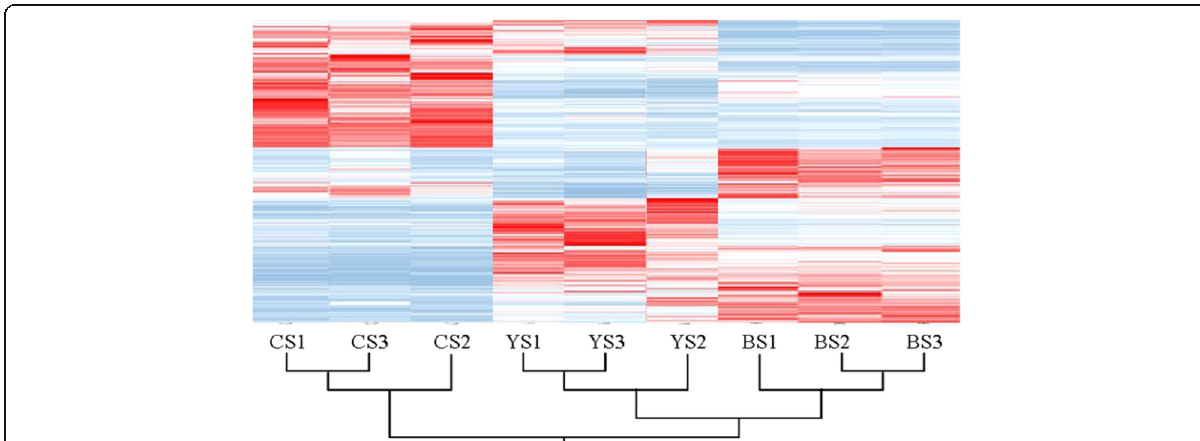
Fig. 2 Hierarchical clustering analysis of all gene models based on expression data. Each horizontal line refers to a gene. The color key represents RPKM normalized log2 transformed counts. With the color varied from blue to red, the expression of transcripts are from low to high. CS 1 to 3, YS 1 to 3 and BS 1 to 3 stand for the replicated samples from CHT025, WFYT025, WFB,